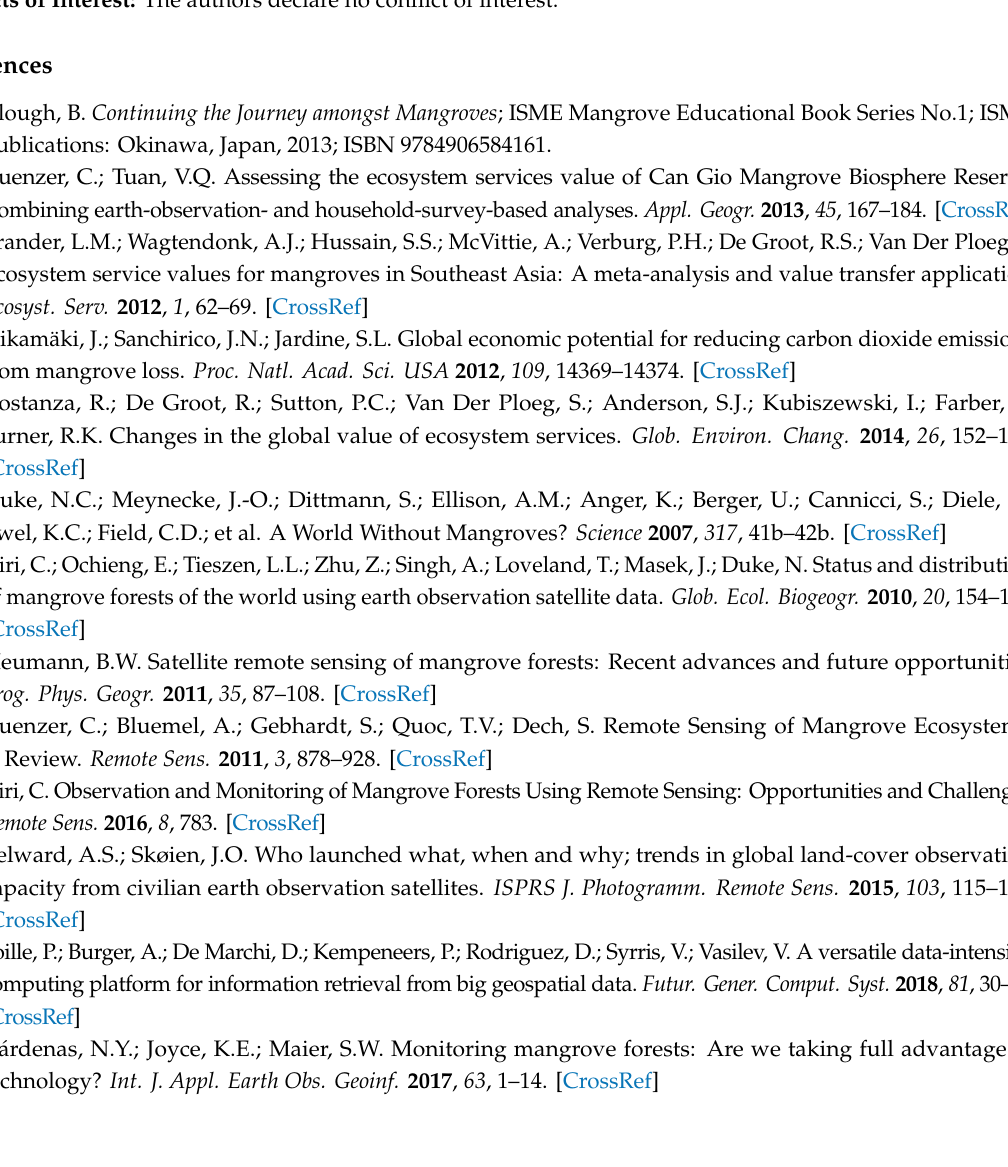
Table S1: Links to the GEE code implementation used for this study, Table S2: Decision rules of the regression tree (CART) build for land use classification (2015) by Landsat-7 and Landsat-8 respectively. Author Contributions: Conceptualization, L.T.H. and N.A.B.; methodology, L.T.H. and N.A.B.; coding, L.T.H.